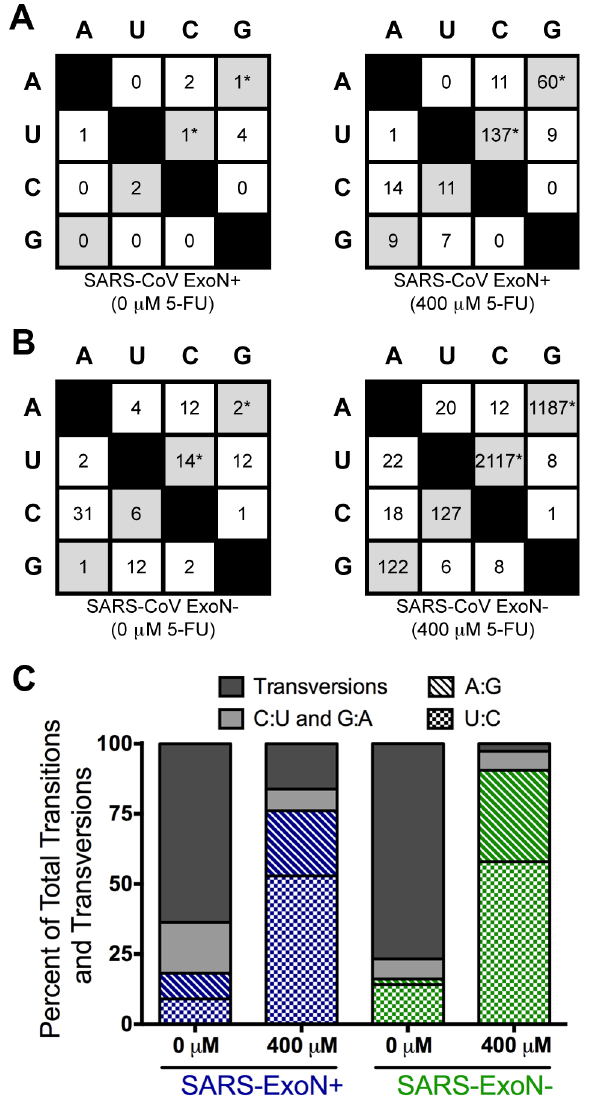
Figure 4. Incorporation of FUMP results in increased U:C and A:G transitions. All possible base changes are shown for SARS-ExoN + and SARS-ExoN 2 viruses in panels ( A ) and ( B ), respectively. Transitions (A « G and U « C) are shaded in grey, and 5-FU specific transitions (U:C and A:G) are marked with an asterisk. Transversions (A « T, A « C, C « G, G « T) are shown in white boxes. All values represent the number of unique statistically significant minority variants following 5-FU treat- ment. ( C ) The percent of all unique statistically significant minority variants represented by transversions (filled dark grey bars), C:U and G:A transitions (filled light grey bars), and the 5-FU specific transitions A:G (hatched bars) and U:C (checkered bars) are shown following 0 or 400 m M 5-FU treatment. SARS-ExoN + viruses are shown in blue, and SARS-ExoN 2 viruses are shown in green.